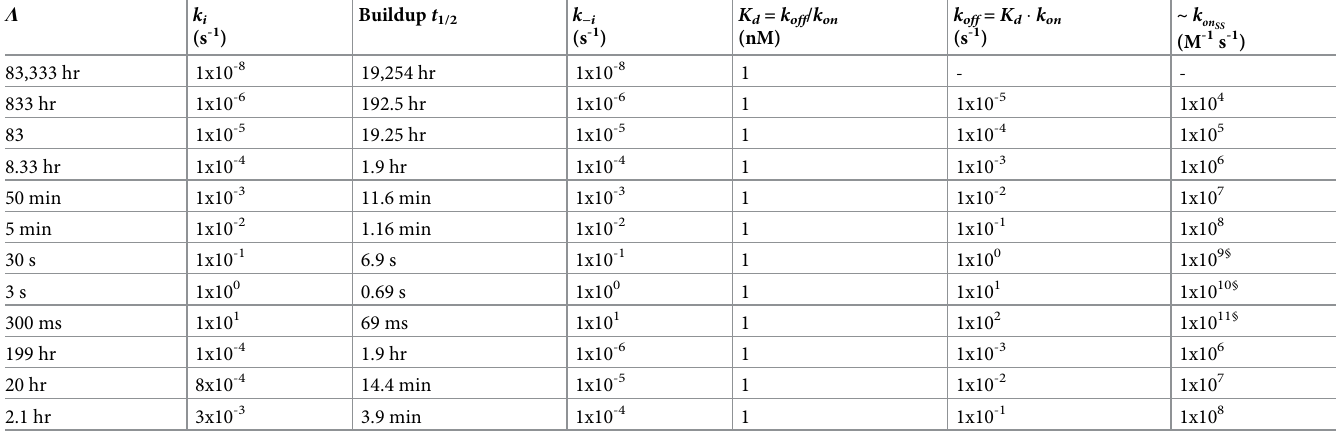
Table 1. Approximate k values needed to achieve the SSO profile as a function of k i , calculated from 10 � k i / L 0 , where L 0 = K d and k off � k − i (noting that k off is not on SS hijacked under these